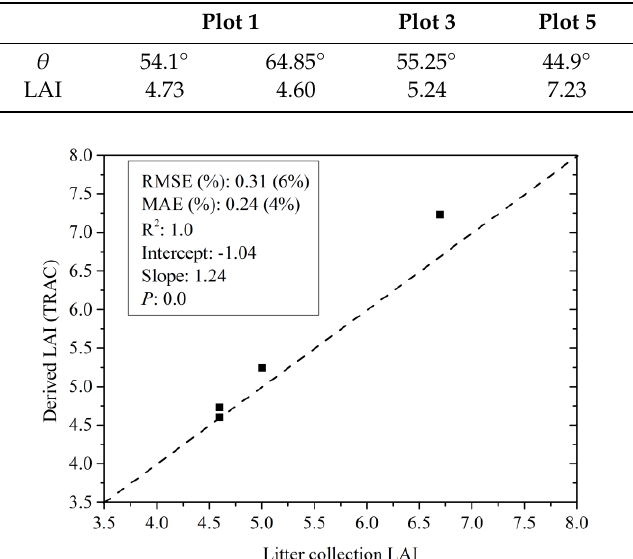
Table 10. LAIs derived using the leaf-on TRAC measurements and destructive woody-to-total area ratio values in the five plots. Only those TRAC measurements collected with a zenith angle near 57° were used for LAI estimation.